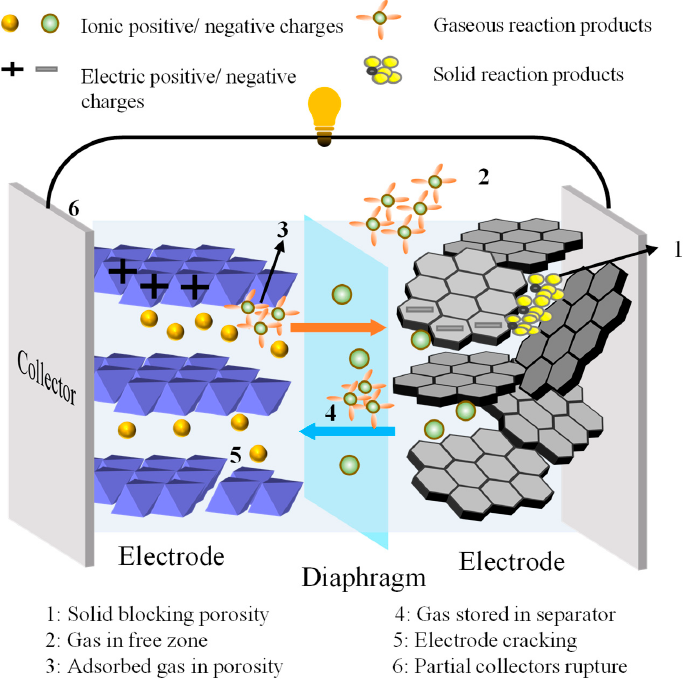
Figure 3. Supercapacitor aging principle [17] . Copyright 2022 Elsevier B.V.